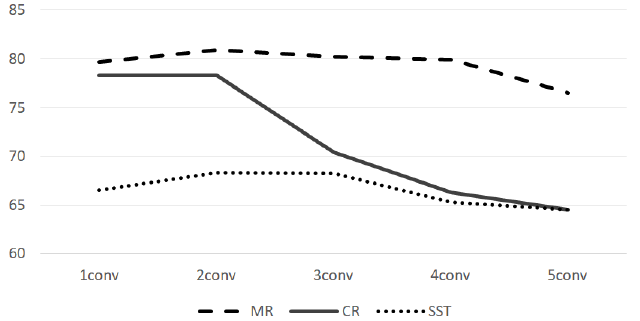
Figure 2. Classification performance according to the depth of the convolutional layer, where the horizontal axis means the number of stacked convolutional layers.